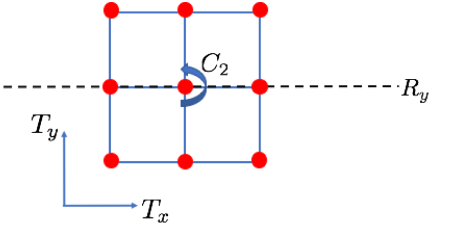
FIG. 4. Square lattice and the relevant symmetries. Each filled red circle represents an odd number of spin- 1 = 2 ’ s. The C 2 rotation is around a site that hosts the spins, and the dashed line is the reflection axis of R y